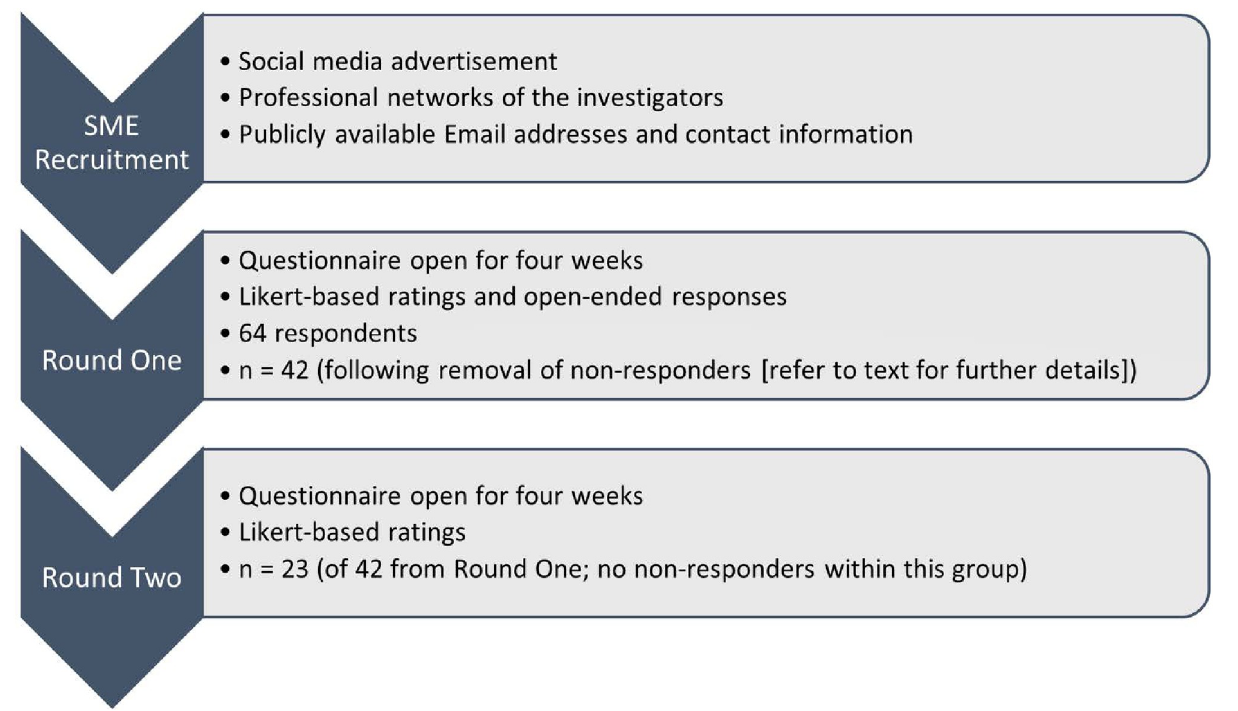
Fig 1. The flowchart of the questionnaire rounds including recruitment, the content of the questions, and the number of respondents to each round of the questionnaire. SME—Subject matter experts.